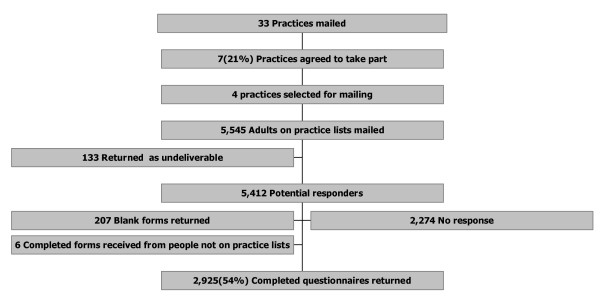
Study schematic.